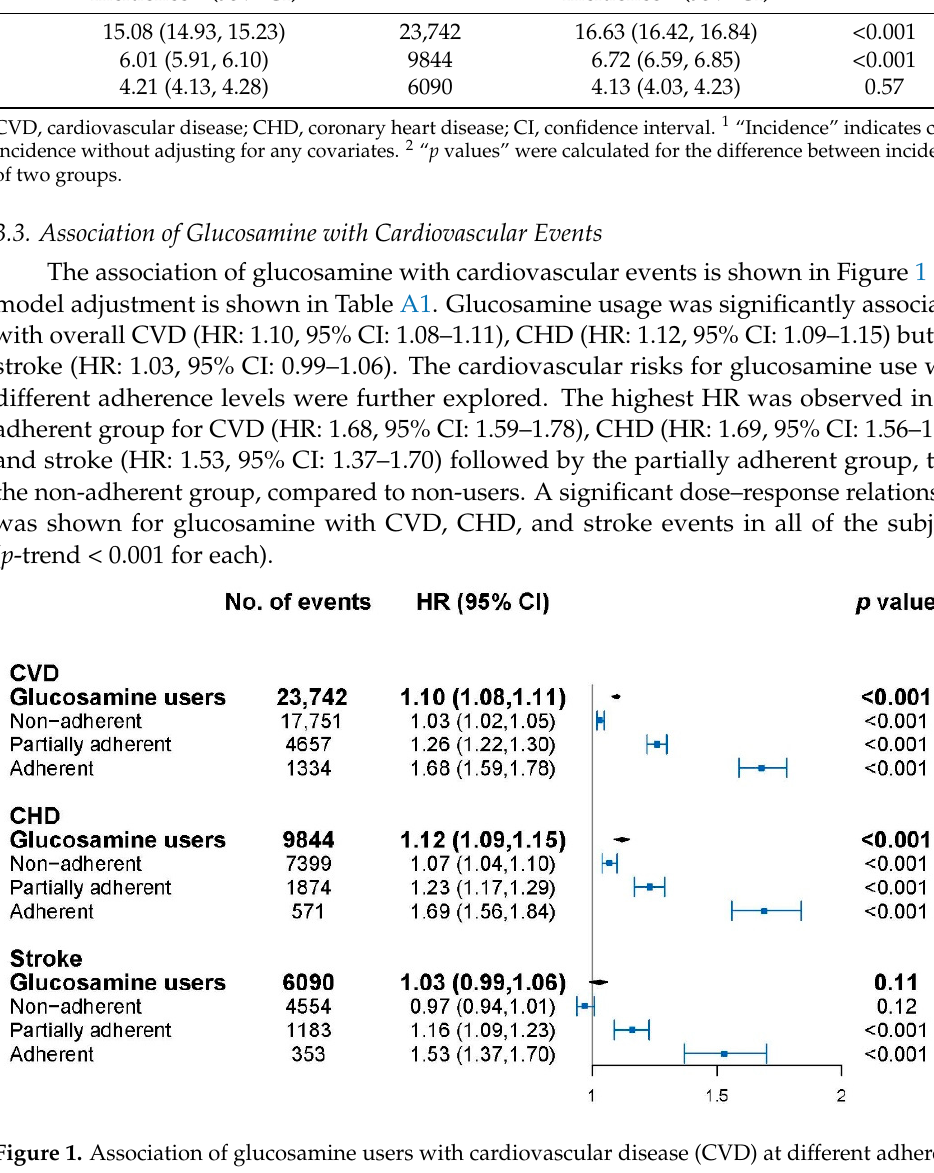
Table 2. Incidence of cardiovascular disease events.